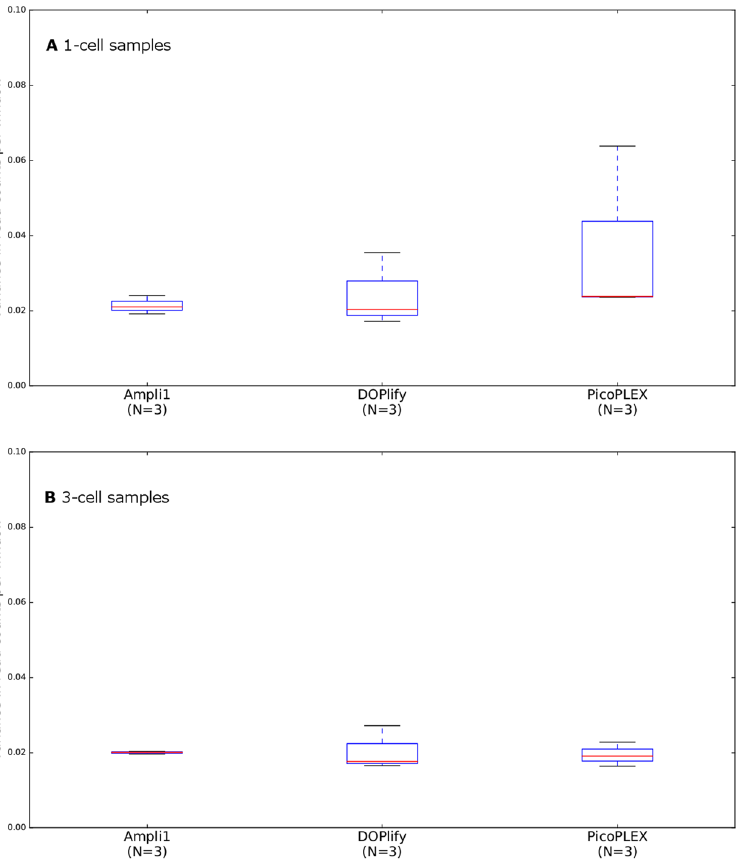
Figure 3. Boxplots of the average variance in read counts per 1 Mb window across the genome. ( A ) Boxplots representing all 1-cell samples for Ampli1, DOPlify and PicoPLEX (Kruskal-Wallis H test p-value = 0.511). ( B ) Boxplots representing all 3-cell samples for Ampli1, DOPlify and PicoPLEX (Kruskal-Wallis H test p-value = 0.829). REPLI-g was omitted from this figure, because it showed a very high average variance in read counts, indicating that the reads were distributed irregularly across the genome. The red line is the median variance for each WGA. The blue box contains the first and third quartile, whereas the black lines represent the minimum and maximum